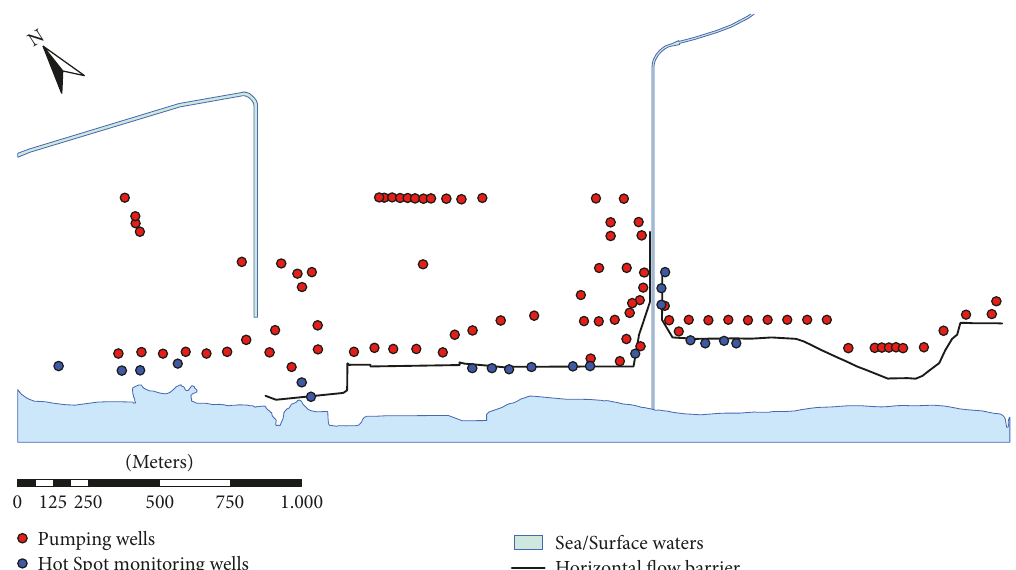
Figure 1: Horizontal flow barrier and hydraulic barrier of the study site. Pumping wells in red and hot-spot monitoring wells in blue.